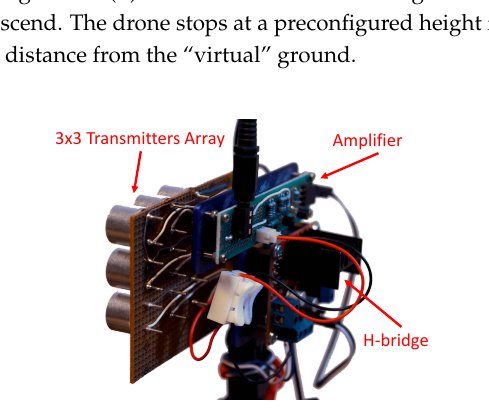
Figure 12. An extended setup of the attacking device composed of three elements: an amplifier, H-bridge, and nine transmitters in a 3 × 3 array. The device can receive a weak signal and amplify it using the